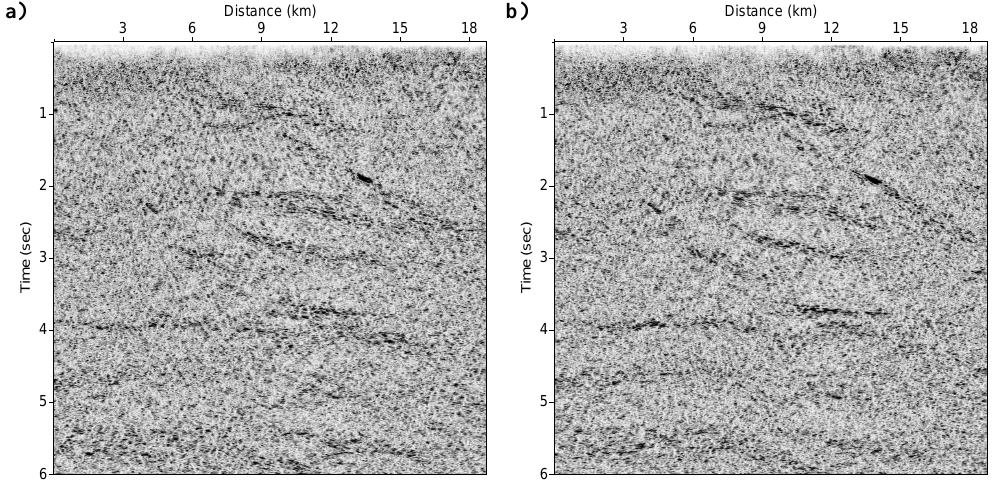
Figure 7. Post-Stack ( a ) and Pre-Stack ( b ) migrated sections for the northern part of Swayze R1